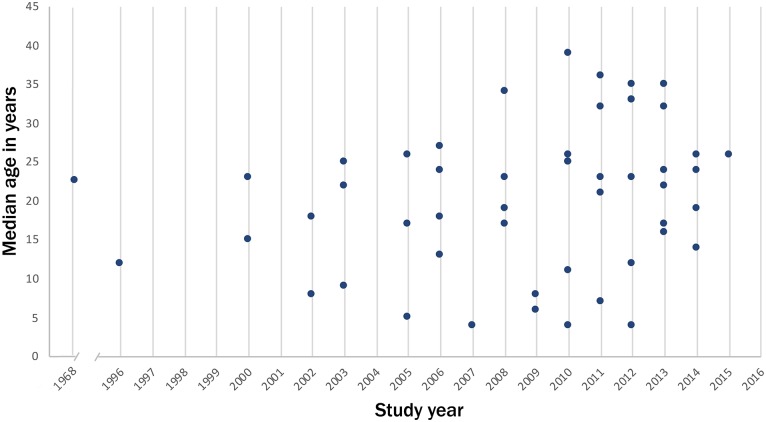
Distribution of median age of laboratory confirmed dengue cases by year of study, India.